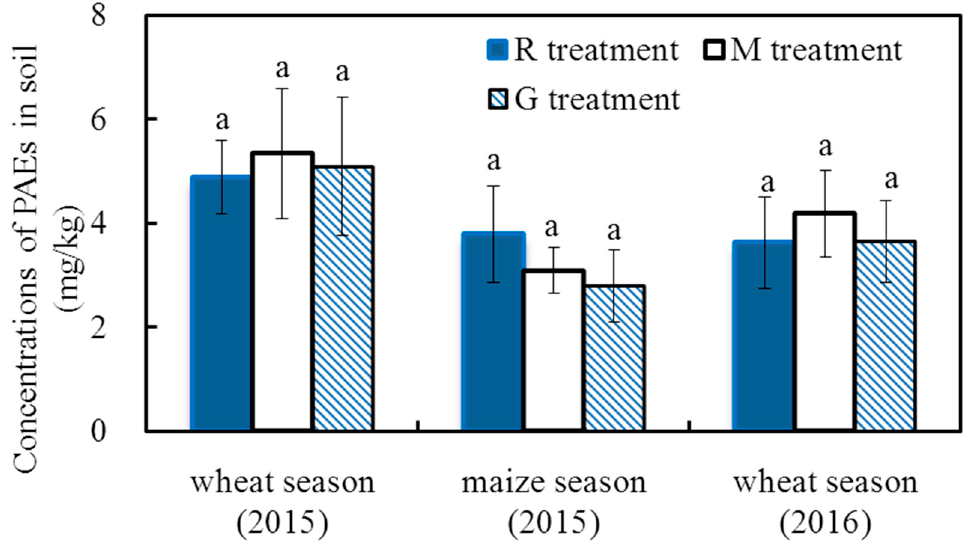
Figure 2. Concentrations of the 6 PAEs in the soil at crop harvest in 2015 and 2016. Note: Different letters on the top of the histogram indicate significant differences among the three treatments for each crop season ( p < 0.05).